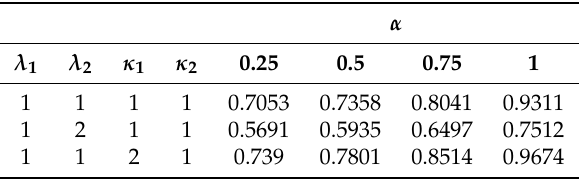
Table 2. Value of parameter p from numerical solution.